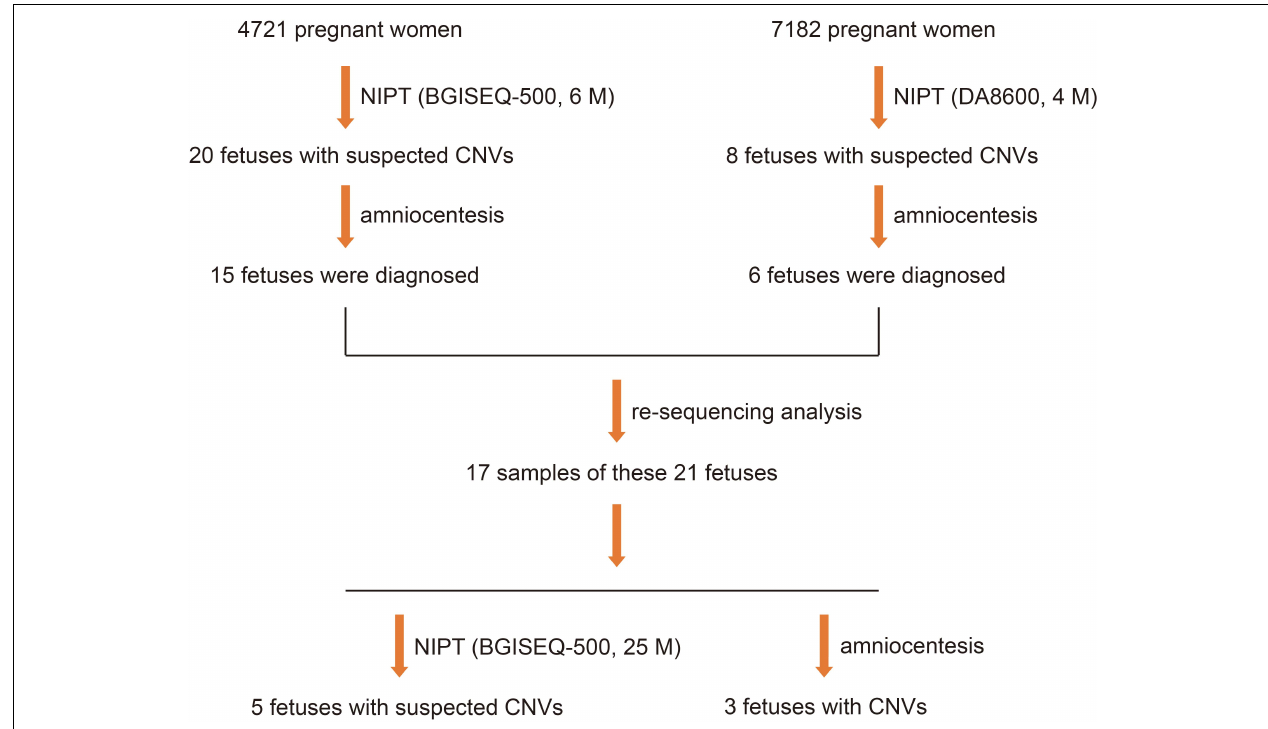
FIGURE 3 | Five positive results in 21 fetuses with suspected CNVs, detected using NGS at read depths of 4–6 M first and then by NGS on the BGISEQ-500 sequencing platform at a read depth of 25 M.